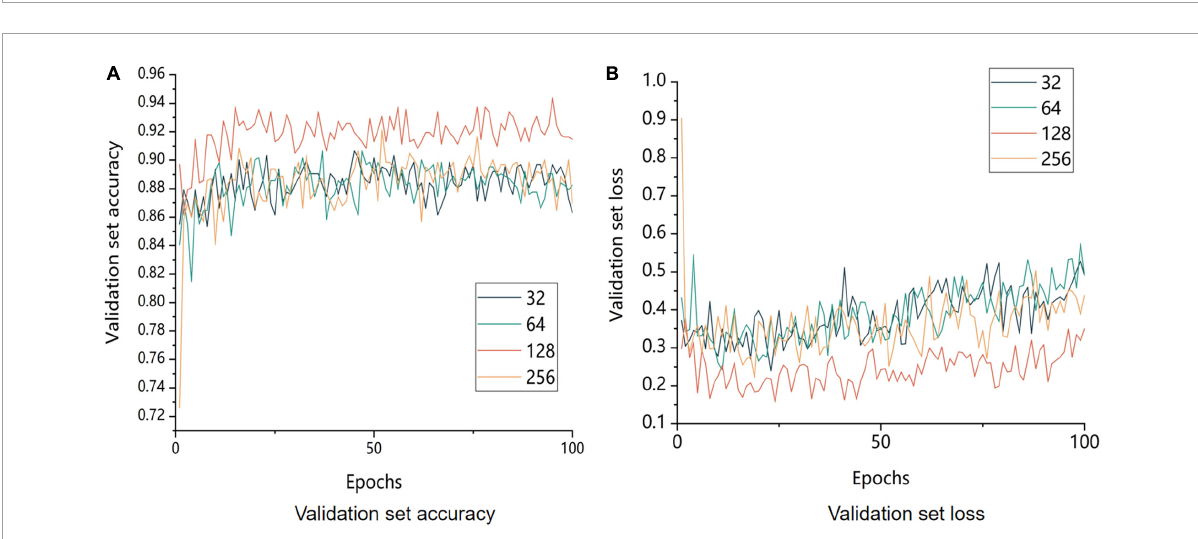
FIGURE12 Comparison of accuracy and model loss of the validation set with different batch sizes. 32 means that the batch size is set to 32; 64 means that the batch size is set to 64; 128 means that the batch size is set to 128; and 256 means that the batch size is set to 256. (A) Image of the change in accuracy of the validation set and (B) image of the change in loss value of the